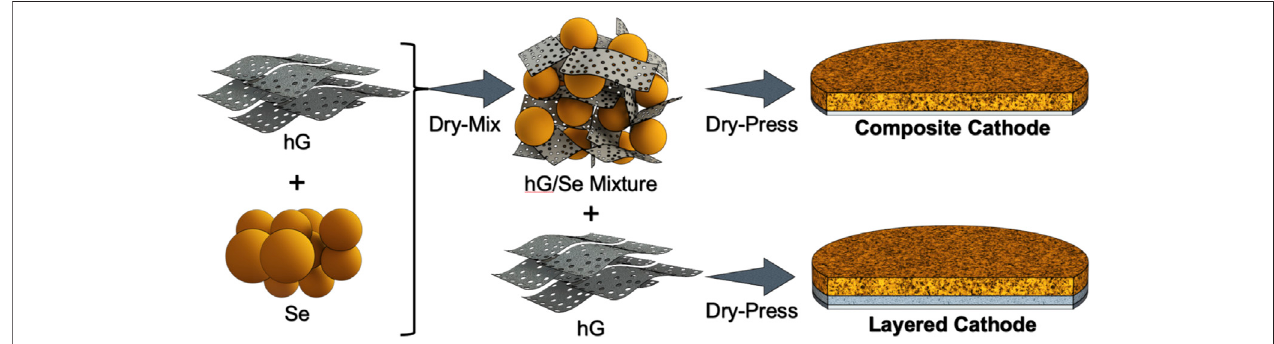
FIGURE 1 | Schematic illustration of the solvent-free mix-and-press process: (left) mix hG and Se powder into the hG/Se composite mixture; (right top) directly press the hG/Se composite mixture onto the current collector to form a composite cathode disc; (right bottom) press sequentially loaded hG powder and the composite mixture powder to form a layered cathode disc, with a hG layer between the composite and the current